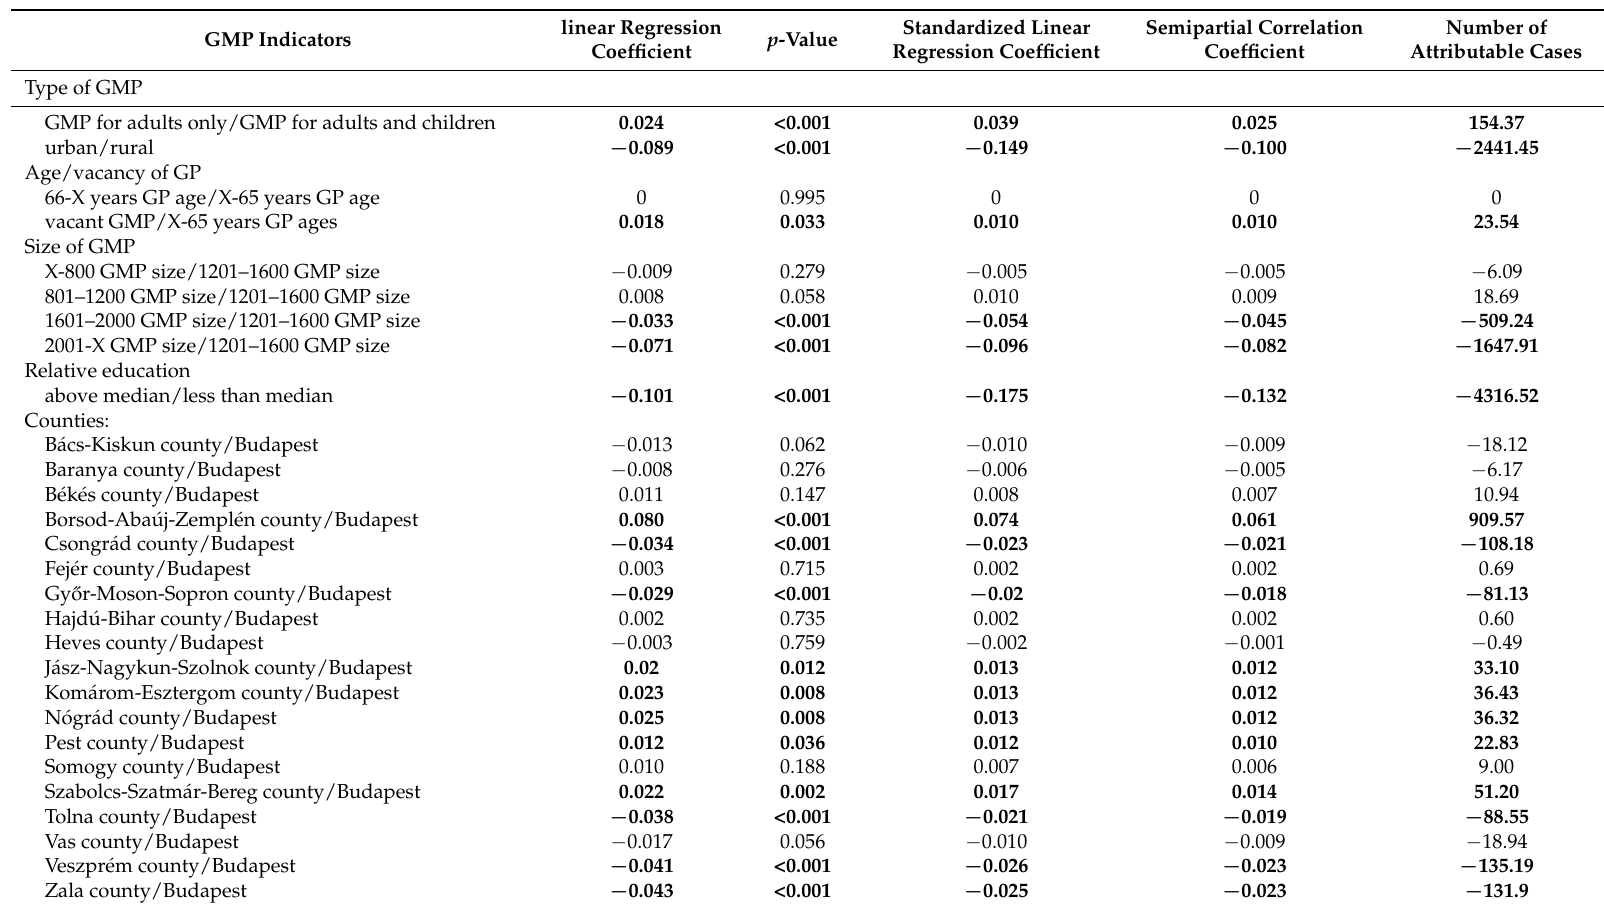
Table 3. Multivariate linear regression analysis of the associations between structural general medical practice (GMP) indicators and age- and gender-standardized annual and GMP-specific mortality ratios among adults aged 18–65 years who did not change GMP in the 5 years prior to the investigated year in Hungary during 2006–2014. linear Regression Standardized Linear Semipartial Correlation Number of p -Value GMP Indicators Coefficient Regression Coefficient Coefficient Attributable